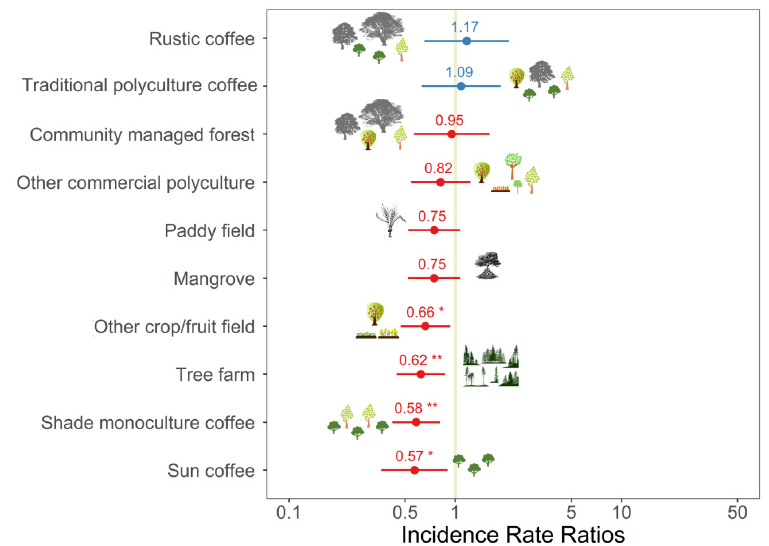
Figure 4. Incidence rate ratios between the richness of birds in commercial polyculture coffee (reference category) and other habitats considered during the survey on 1228 plots in Java, Indonesia. Data are standardised beta values and 95% confidence intervals from a generalised additive model. A description of the habitats can be found in the methods. Other predictors included in the model can be found in Table 2. * p < 0.05; ** p < 0.01. Table 2. Results of generalised additive models to understand the influence of habitat type and other environmental predictors on the abundance, diversity, and richness of birds in 21 sites, 1226 plots, in Java, Indonesia.